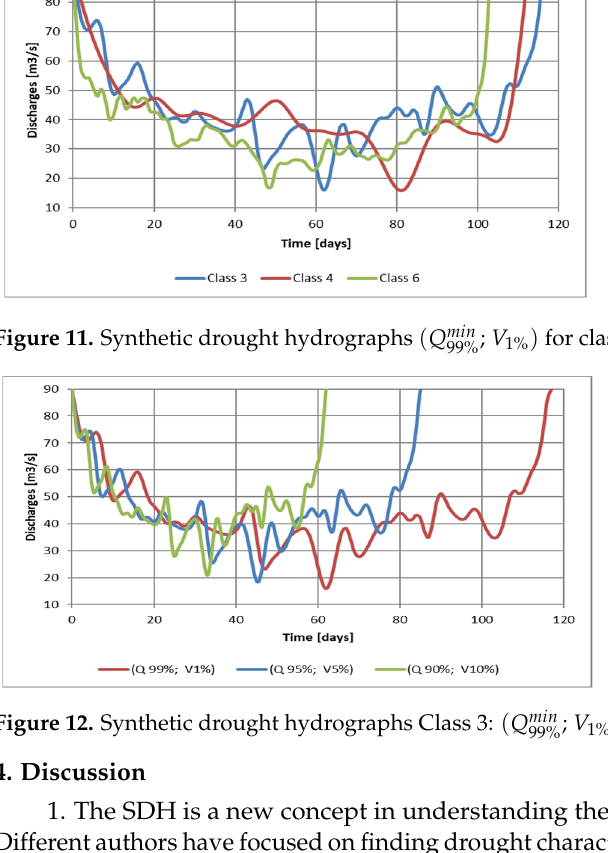
Figure 12. Synthetic drought hydrographs Class 3: (cid:4666)𝑄 (cid:2877)(cid:2877)%(cid:3040)(cid:3036)(cid:3041) ; 𝑉 (cid:2869)% (cid:4667) ; (cid:4666)𝑄 (cid:2877)(cid:2873)%(cid:3040)(cid:3036)(cid:3041) ; 𝑉 (cid:2873)% (cid:4667) ; (cid:4666)𝑄 (cid:2877)(cid:2868)%(cid:3040)(cid:3036)(cid:3041) ; 𝑉 (cid:2869)(cid:2868)% (cid:4667) .